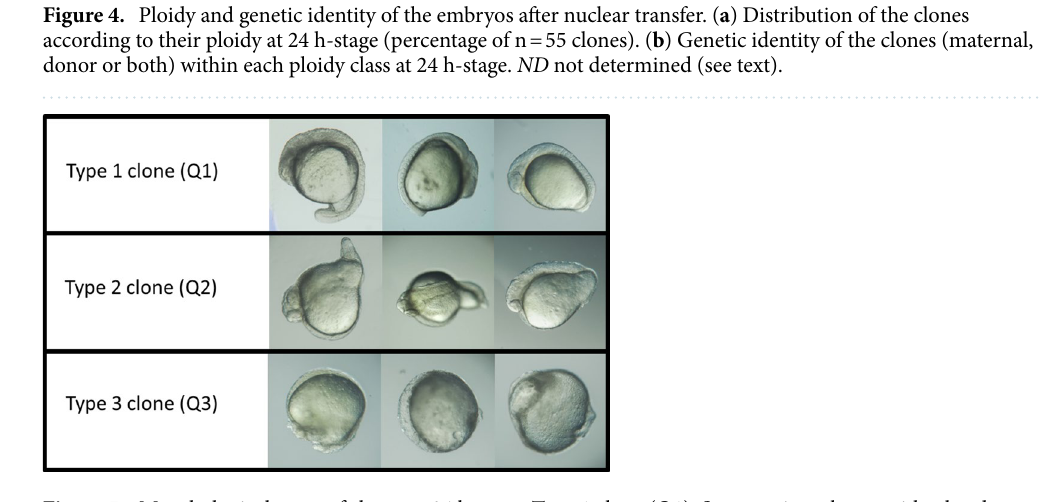
Figure 5. Morphological types of clones at 24 h-stage. Type 1 clone (Q1): Symmetric embryos with a head, a trunk with well-defined somites, and a developed tail. Type 2 clone (Q2): embryos with a developed head, a trunk with or without somites, and a tail bearing deformity. Type 3 clones (Q3): poorly structured embryo, never presenting simultaneously a head, a trunk and a